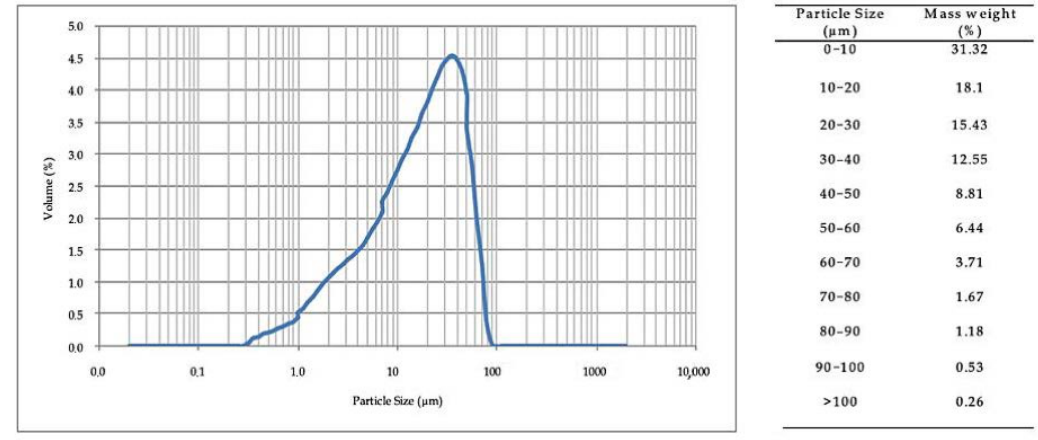
Figure 1. Mineral particle